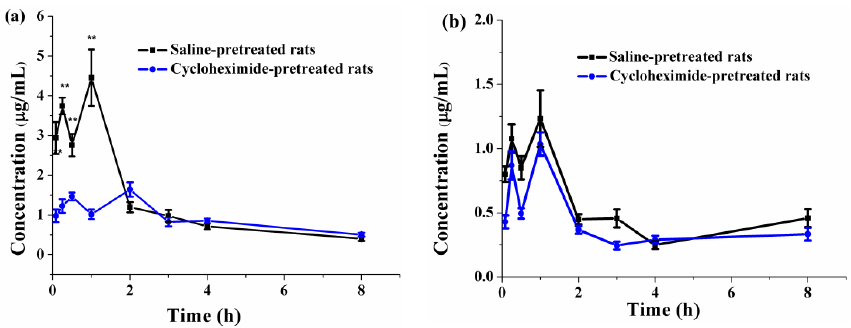
Figure 7. Plasma concentration–time profiles for oral administration of ( a ) PFs-SMEDDS NR and ( b ) PFs-suspension in cycloheximide-pretreated and saline-pretreated rats (mean ± SD, n = 5; ** p < 0.01).